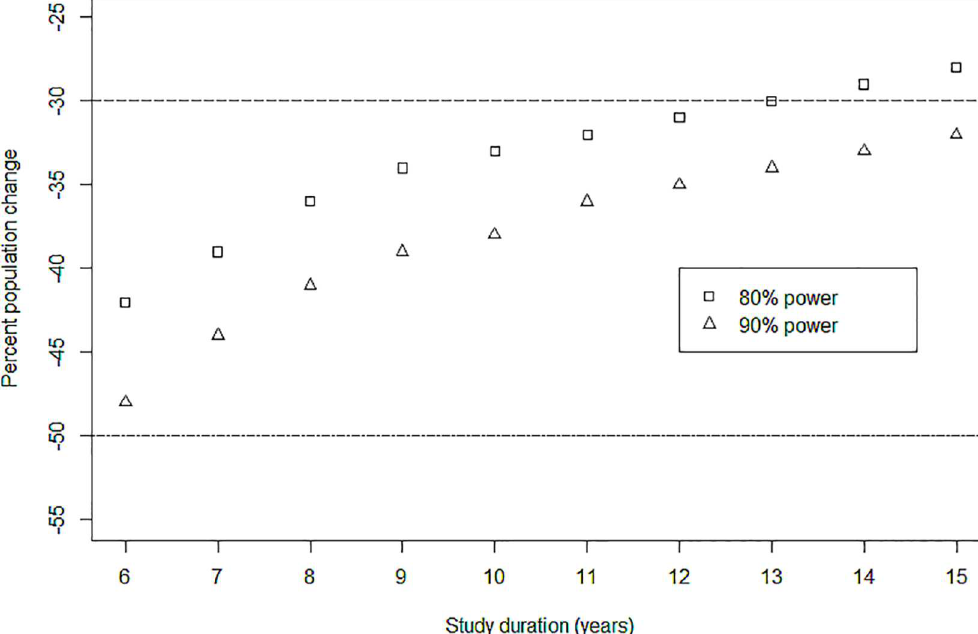
Fig 3. Power analysis for striped dolphins. Percent populationchangesthat we were able to detect for striped dolphins,with a power of 0.8 (squares) and 0.9 (triangles),as a function of the durationof the study (yearly samples). The dashed lines indicatea percent population change of respectively -50 and